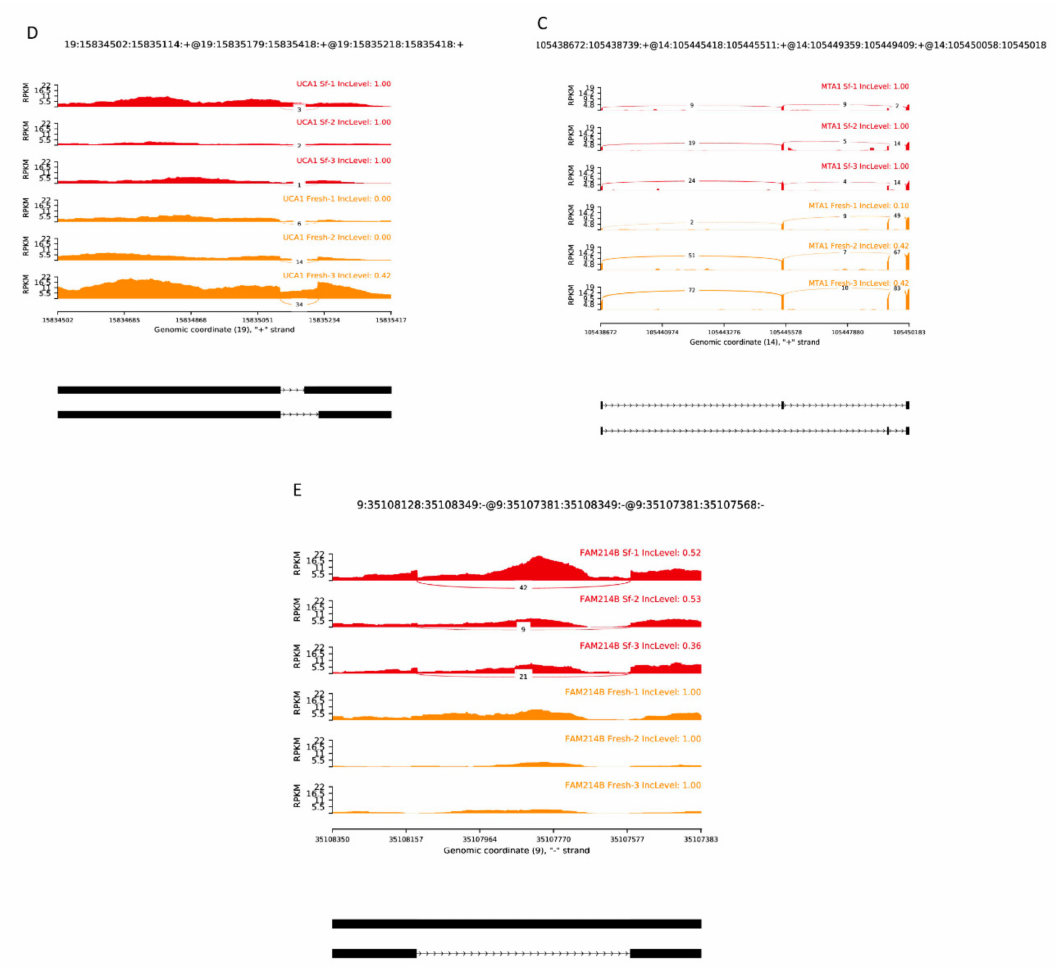
Figure 6. Examples of different types of alternative splicing events analyzed by rMATS. ( A ) Exon skipping diagram of DDX46 in cryoprotectant-free vitrified spermatozoa group. ( B ) Alternative 5 (cid:48) splice site graph of LINC01359 in conventionally frozen spermatozoa group. ( C ) Mutually exclusive exon graph of MTA1 in conventionally frozen spermatozoa group. ( D ) Alternative 3 (cid:48) splice site graph of UCA1 in conventionally frozen spermatozoa group. ( E ) Retained intron graph of FAM214B in conventionally frozen spermatozoa